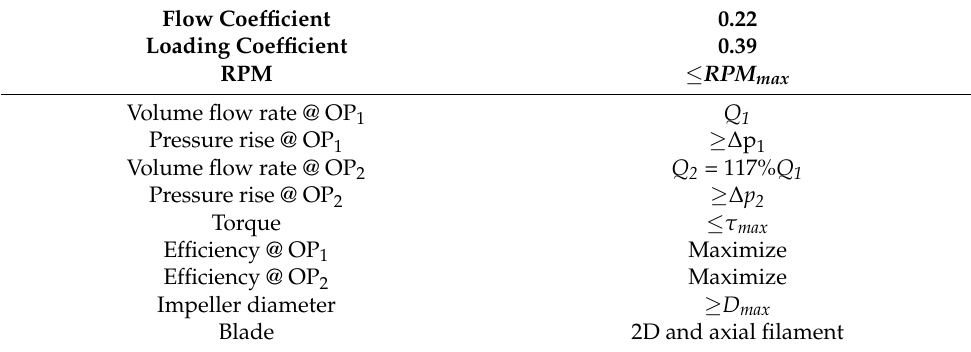
Table 1. Design specifications and constraints.